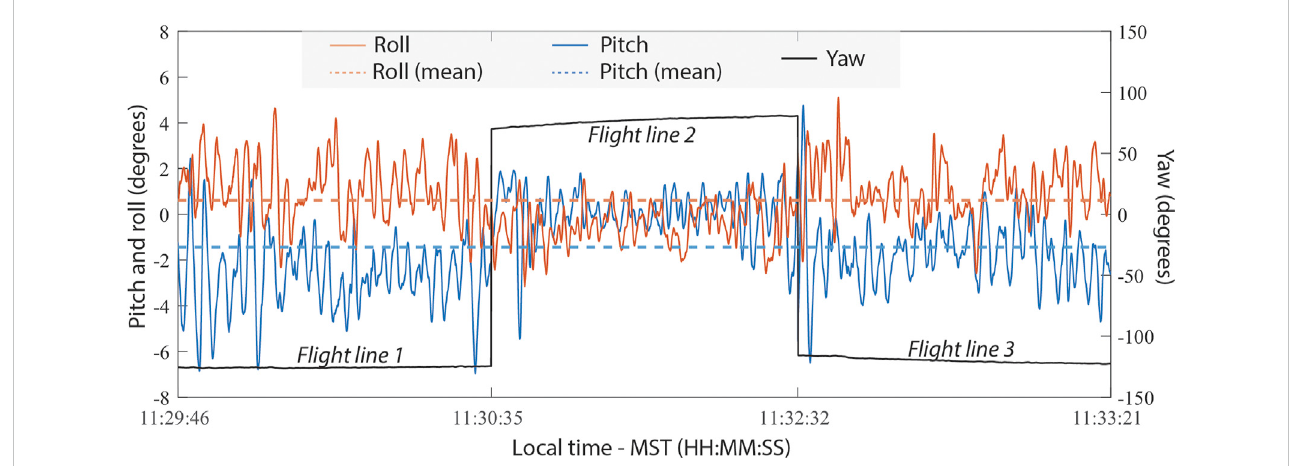
FIGURE 7 Roll, pitch, and yaw of the UAV during the fl ight collected from the inertial measurement unit